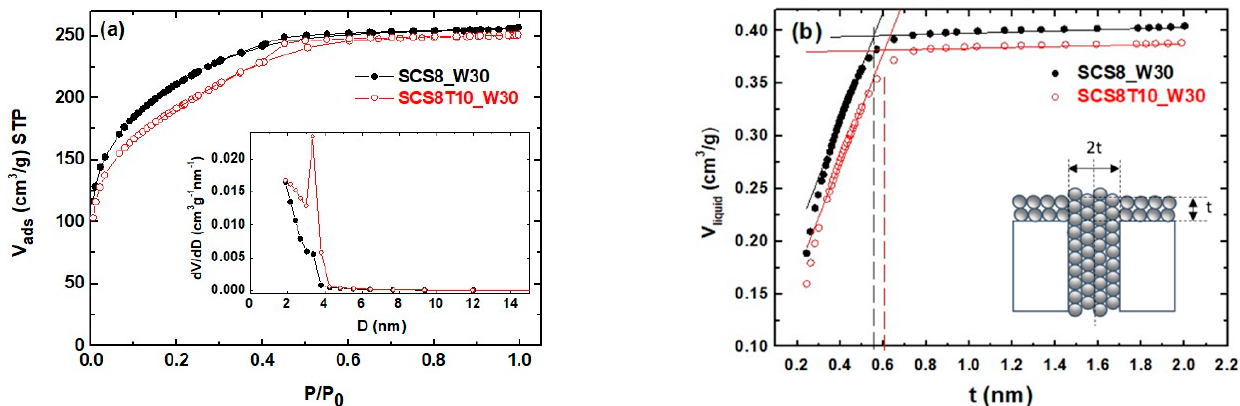
Figure 3. ( a ) N 2 isotherms and PSD (inset) of SCS8_W30 and SCS8T10_W30 xerogels ( b ) t-plot curves indicating the half of the maximum pore width, as schematically shown in the inset [59]. Volume STP adsorbed nitrogen in the y-axis has been converted to the liquid equivalent one.